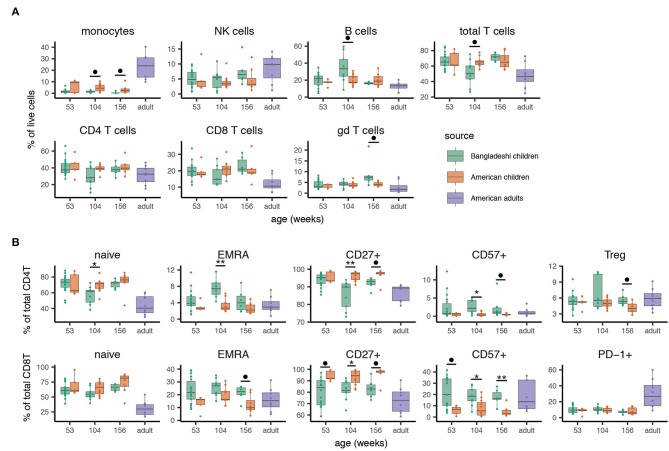
Manual gating validation of altered immune phenotypes associated with location. After identifying cell subsets that differed between Bangladeshi and American cohorts with automated analyses, main cell populations and phenotypes of interest were manually gated. Samples include 24 from American children (week 53 n = 5, week 104 n = 11, week 156 n = 8) and 33 from Bangladeshi children (week 53 n = 18, week 104 n = 9, week 156 n = 6). Cell phenotypes from 8 American adults are shown as a reference for typical values derived from the CyTOF panel and gating scheme utilized here and were not used for statistical analyses. (A) Minor differences in main cell populations are detectable between equivalent-aged Bangladeshi and American children. Bangladeshi children show reduced monocyte and total T cell populations and increased B cell and gamma delta T cell populations compared to American children at select ages. (B) Bangladeshi children show more T cell differentiation and senescence phenotypes but not exhaustion compared to equivalent-aged American children. To compare Bangladeshi and American children's cell populations from manual gating, Mann-Whitney tests were performed for each population and time point shown. p-values were then corrected for multiple testing using the Benjamini and Hochberg method. Significance levels of the cell population differences between Bangladeshi and American children are indicated by FDR < 0.1 (•), FDR < 0.05 (*), FDR < 0.01 (**). Values plotted are means ± SEM.